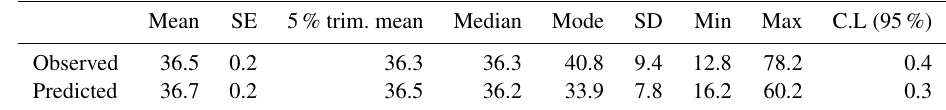
Table 5. Descriptive statistics of observed and predicted values.